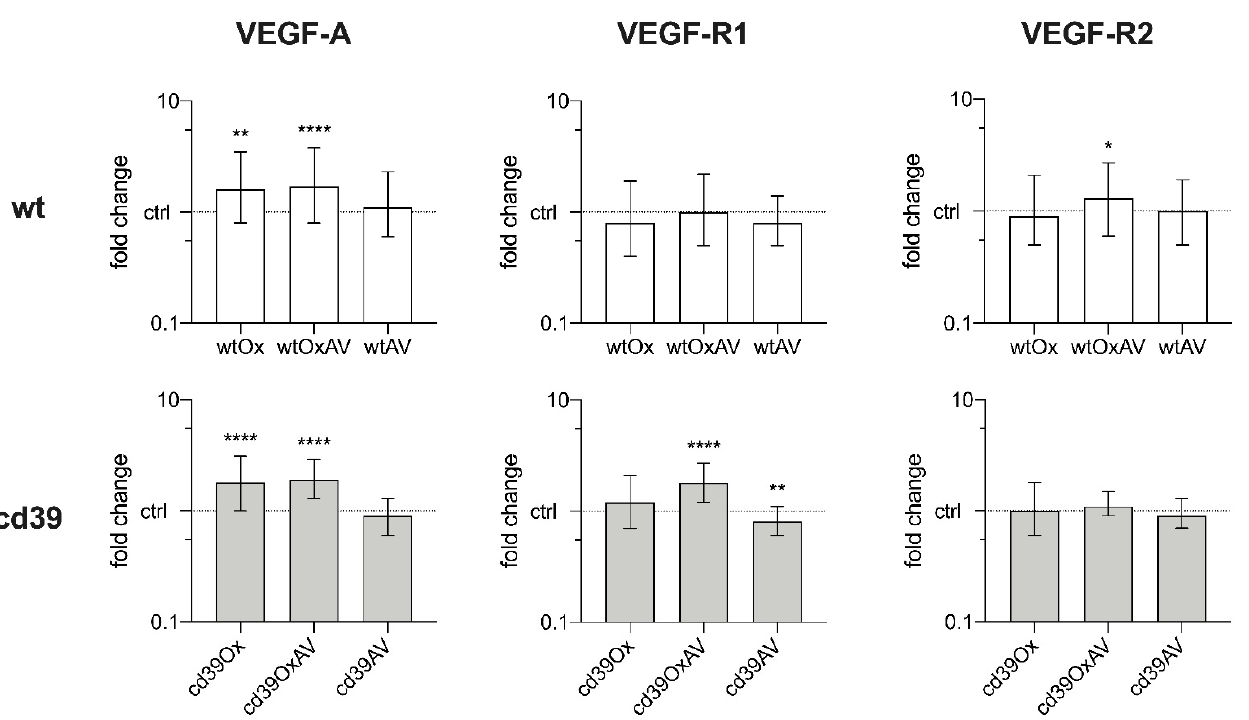
Figure 3. Analysis of quantitative PCR data in resected liver specimen. Median fold change and standard error. wtGlu and cd39Glu served as controls. (* p ≤ 0.05, ** p ≤ 0.01, **** p ≤ 0.0001) ( Left column ). VEGF-A. Expression of VEGF-A was significantly up-regulated in mice receiving oxaliplatin-containing regimens (wtOx: p = 0.004, wtOxAV: p < 0.0001, cd39Ox: p < 0.0001, and cd39OxAV: p < 0.0001). However, VEGF-A was equivalently expressed between groups receiving oxaliplatin (wtOx/wtOxAV: p = 0.786, cd39Ox/cd39OxAV: p = 0.990). ( Middle column ). VEGF-R1. In wt mice, VEGF-R1 expressions were comparable. In cd39-null mice compared to controls, VEGF-1 was equivalently expressed in cd39Ox ( p = 0.137), up-regulated in cd39OxAV ( p < 0.0001), and down-regulated in cd39AV ( p = 0.007). ( Right column ). VEGF-R2. Most importantly, VEGF-R2 was up-regulated in wtOxAV ( p = 0.045) compared to controls, while it was comparable among cd39-null mice ( p = 0.112).